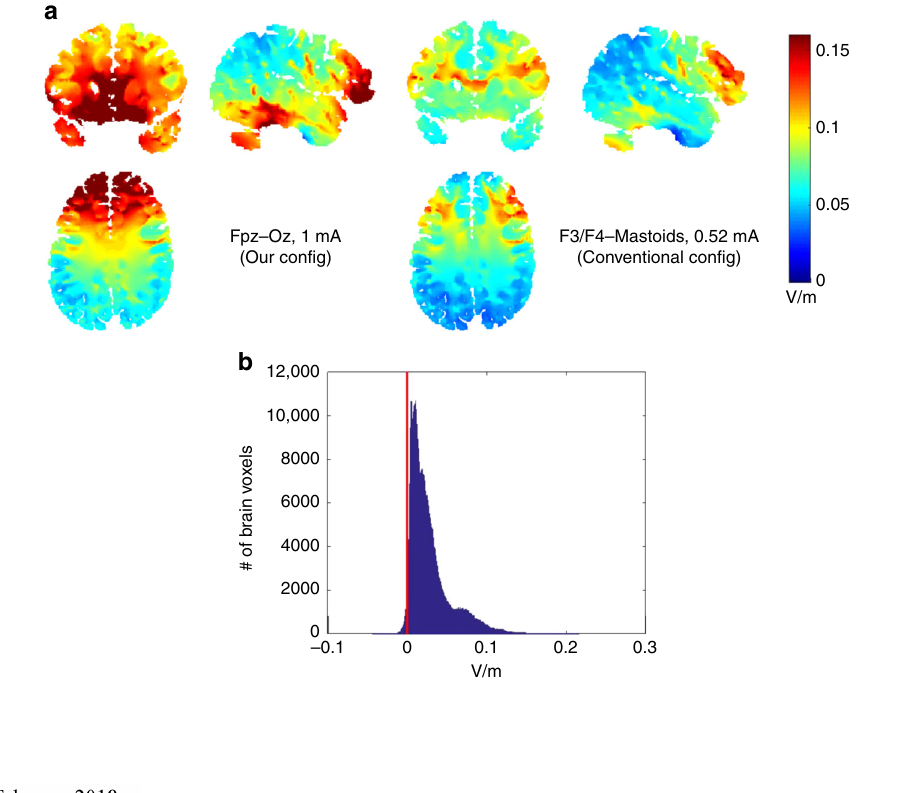
F3/F4–Mastoids, 0.52 mA (Conventional